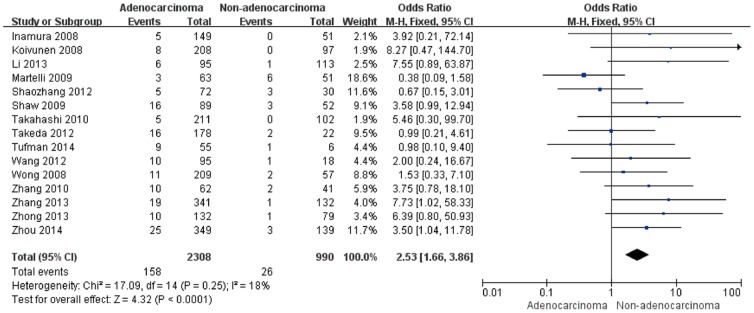
Forest plots of studies with an association between the EML4-ALK fusion gene and pathologic type.